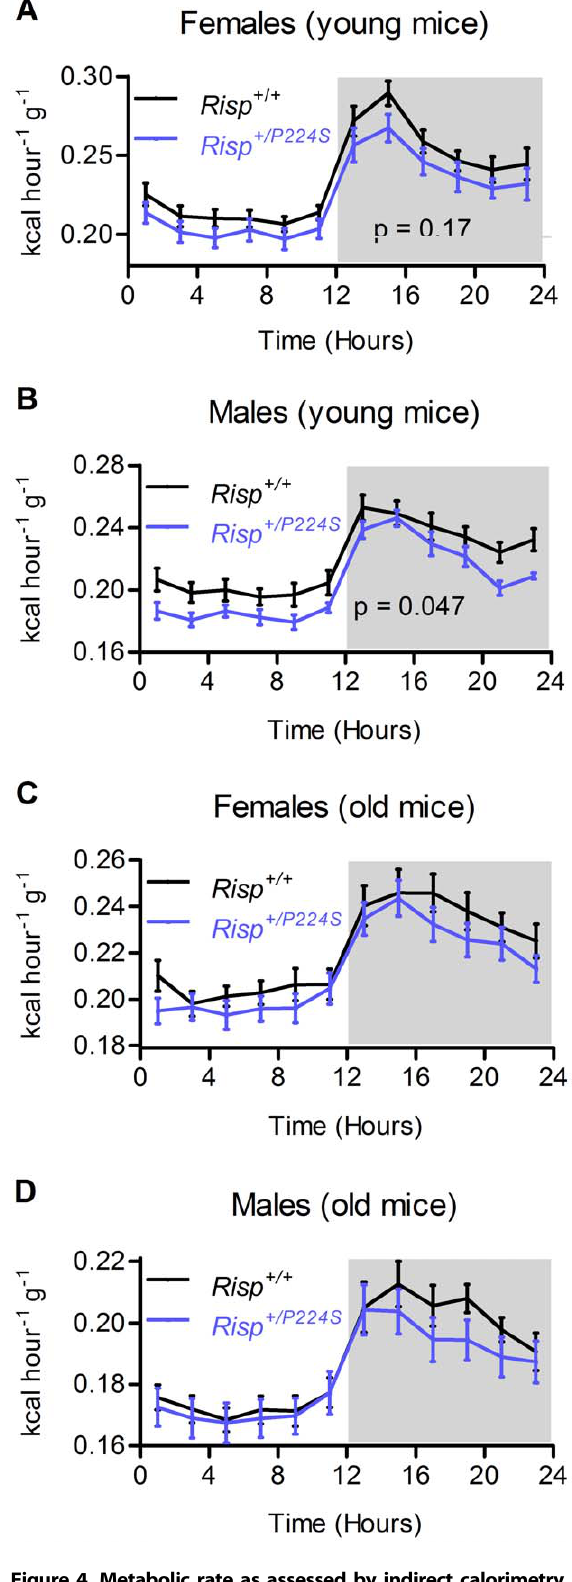
Figure 4. Metabolic rate as assessed by indirect calorimetry per- formed over a 24 hour period. The dark period is shaded. ( A ) Metabolic ratefor3-month-oldfemalemice(n=13).( B )Metabolicratefor3-month-old male mice (n=12). ( C ) Metabolic rate for 2-year-old female mice (n=19 and 21). ( D ) Metabolic rate for 2-year-old male mice (n=17 and 18).